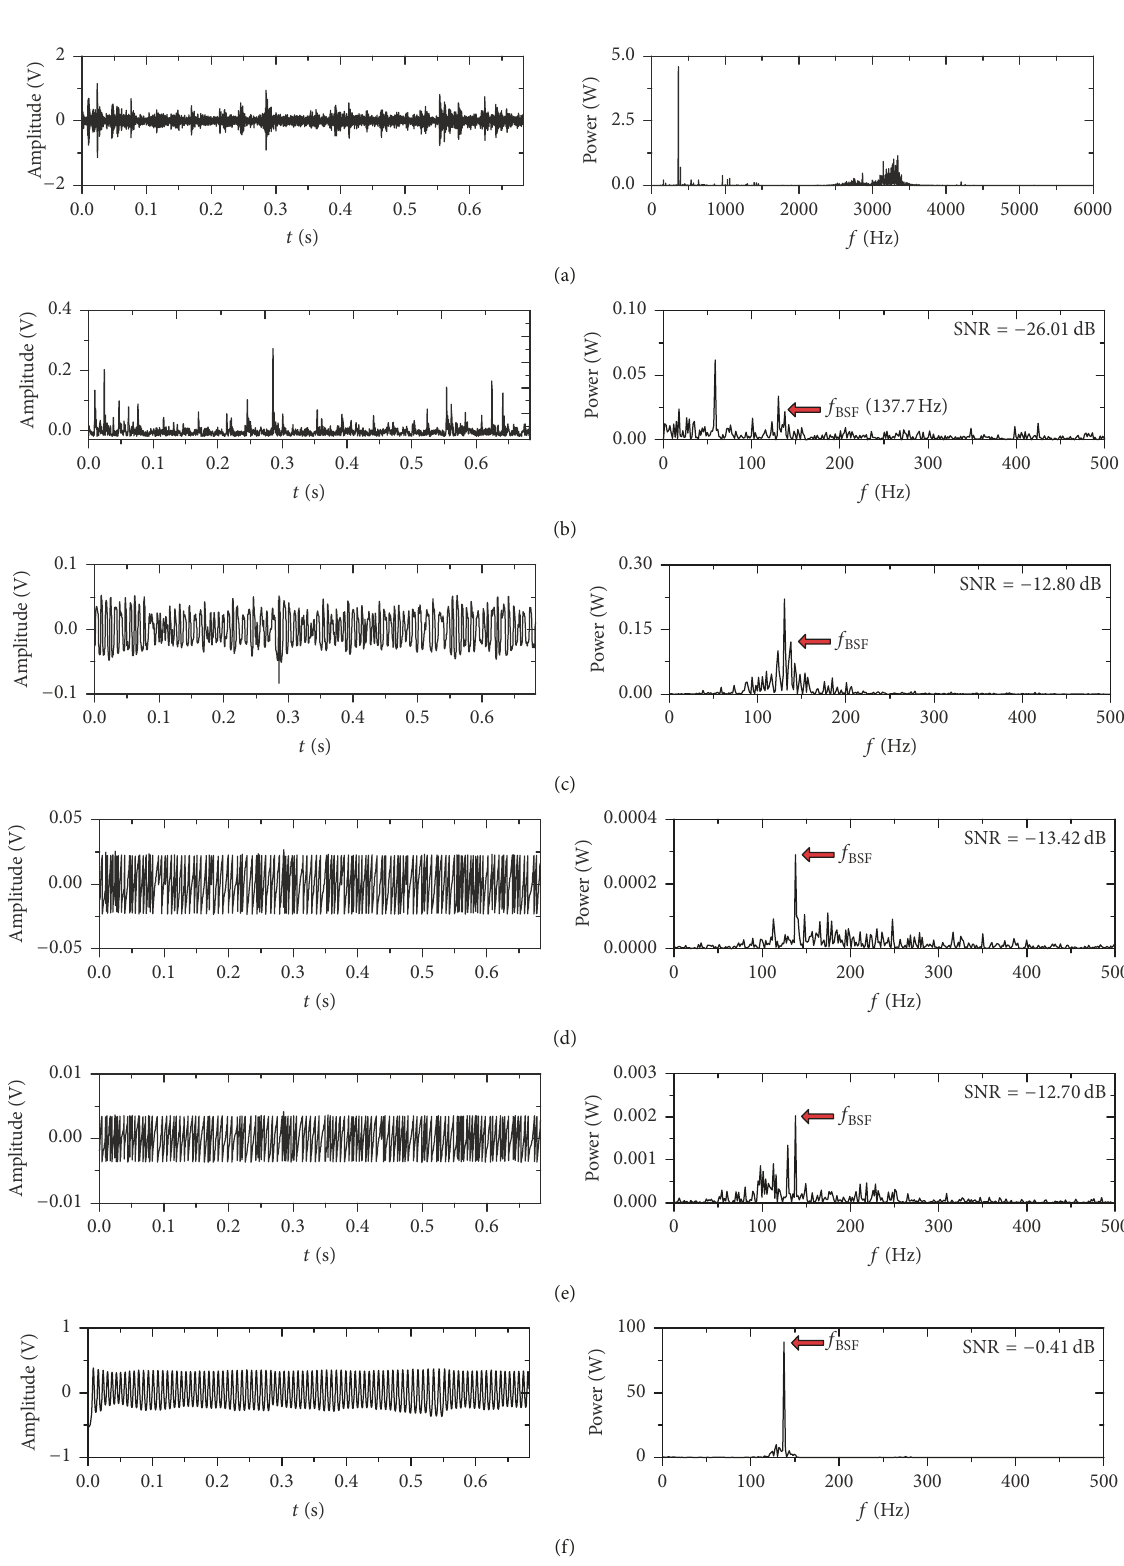
Figure 13: Analysis results for the bearing signal with a defective rolling element: (a) original signal; (b) envelope signal with a filtering band at 3750–4500 Hz; (c) optimal MSTSR output signal (optimal parameters: 𝑎 = 2𝑒 − 14 , 𝑏 = 8800 , ℎ = 0.034 , and 𝐾 = 6 ); (d) optimal WSSR output signal (optimal parameters: 𝑅 1 = 0.002 , 𝑉 0 = 10 , 𝑐 = 1.5 , and ℎ = 0.004 ); (e) optimal WSGSR output signal (optimal parameters: 𝑅 = 1𝑒 − 3 , 𝑅 = 3.7 , 𝑉 = 12 , 𝑉 = 0.5 , 𝑐 = 1.3 , and ℎ = 0.007 ); and (f) optimal SVVR output signal (optimal parameters: 𝑎 = 1.9 , 𝑏 = 4.6 , 1 2 0 1 𝛾 = 8𝑒 − 5 , ℎ = 0.044 , 𝐵 = 0.006 , and Ω = 12354